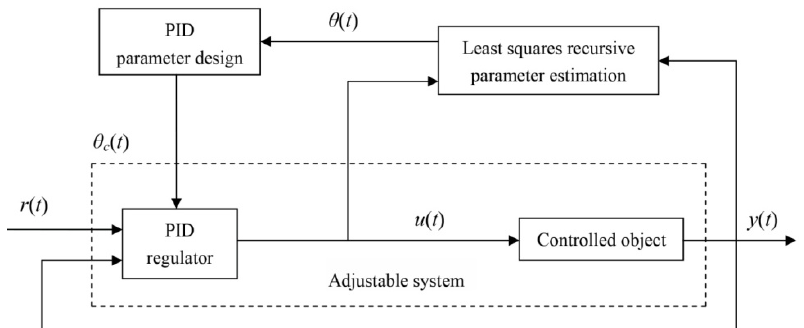
Figure 4. Structure diagram of self-tuning PID control system.